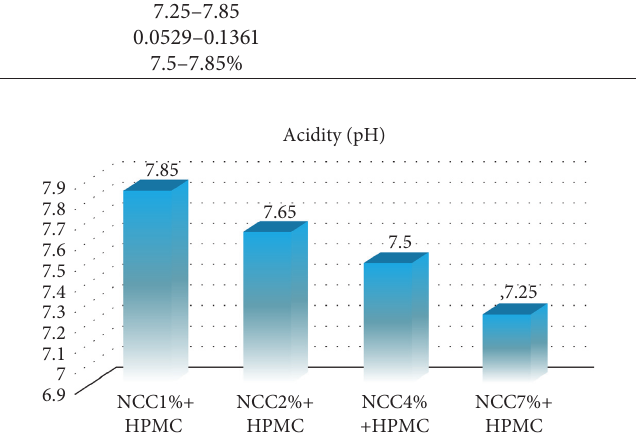
Figure 4: The pH value for 1%, 2%, 4%, and 7% NCC with hydroxypropyl methylcellulose (HPMC). Table 4: Gel strength results of the capsule shells from NCC produced from sugarcane bagasse waste added with hydroxypropyl methylcellulose